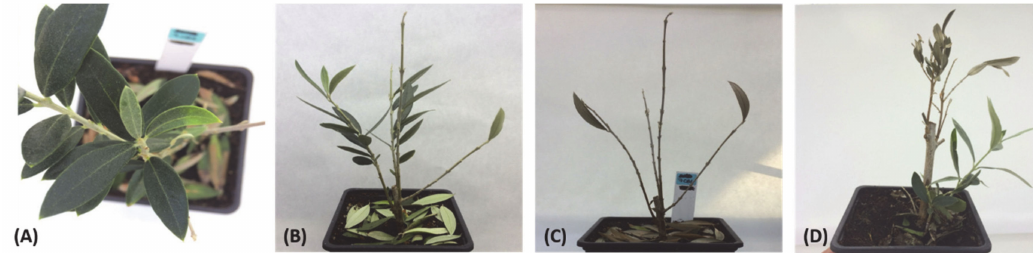
Figure 4. Symptoms observed upon the artificial inoculation of the defoliating pathotype of Verticillium dahliae in olive plants cultivar Picual. ( A ) Chlorotic and distorted leaf; ( B ) partial severe defoliation (a ff ecting some stems) of green leaves; ( C ) fully defoliated dead plant; ( D ) olive plants may undergo the so-called natural recovery phenomenon (see, for instance, L ó pez-Escudero and Mercado-Blanco, 2011